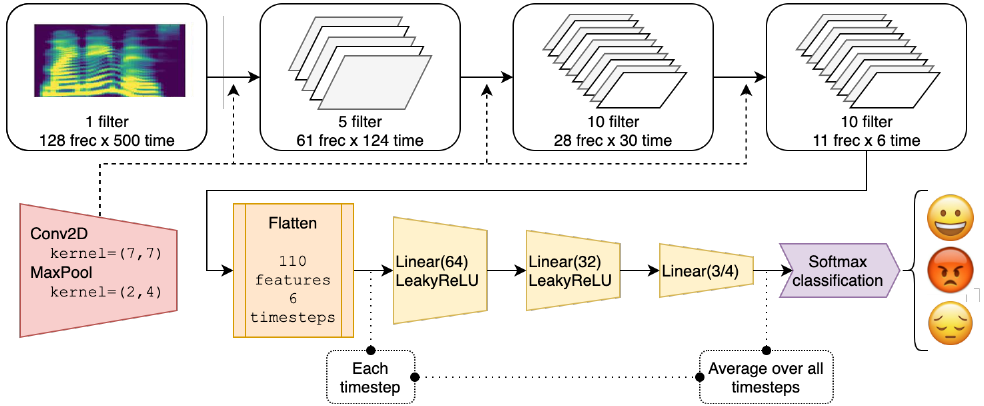
Figure 3. Neural network architecture used for classification when the spectrogram represents the speech signal. First, a succession of convolutional and maxpooling layers reduce the dimensions, obtaining a small time dimension with 110 features each (10 filters times 11 frequencies). Then, some logits are obtained for each of the features of the time dimension over three linear layers. Finally, the mean of all of the logits is computed to classify the